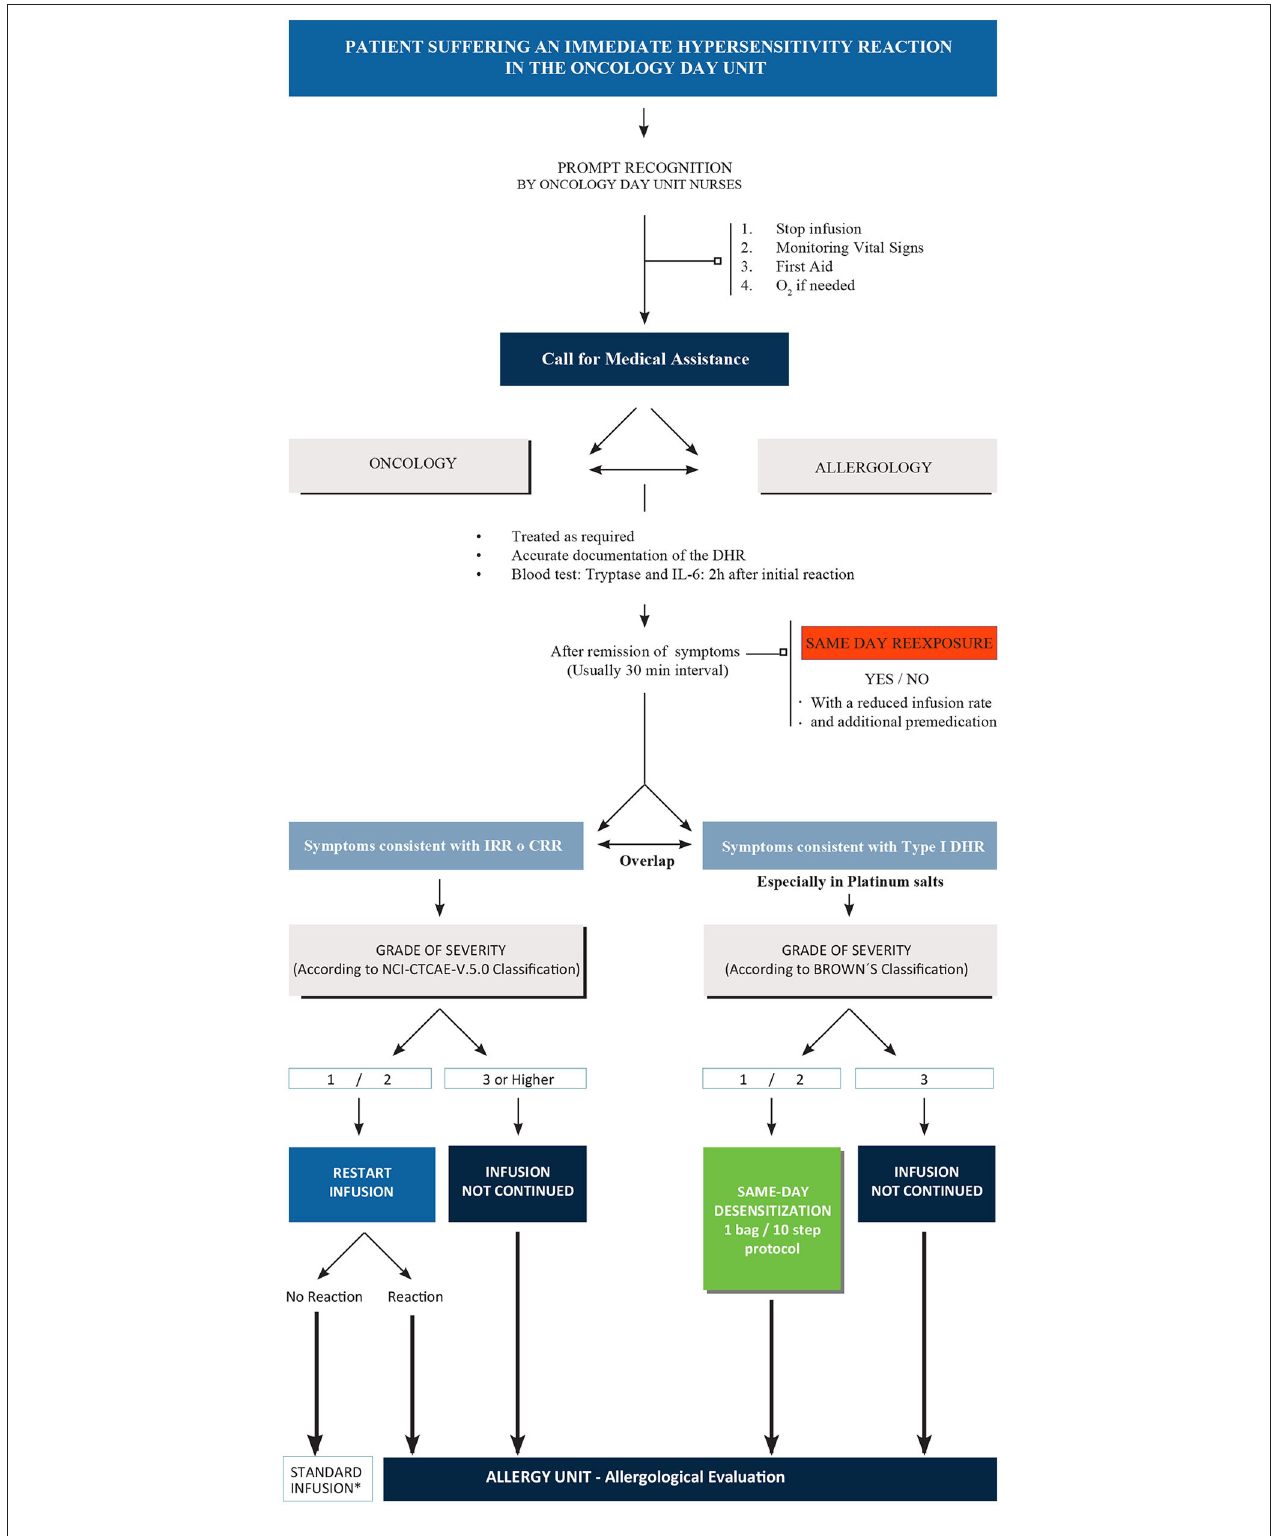
FIGURE 1 | Complete diagnostic/therapeutic flowchart. IRR, infusion related reaction; CRR, cytokine release reaction; DHR, drug hypersensitivity reaction; NCI-CTCAE, National Cancer Institute Common Terminology Criteria for Adverse Events. * First-time patients controlled by allergist. For high risk patients, allergological evaluation is mandatory.